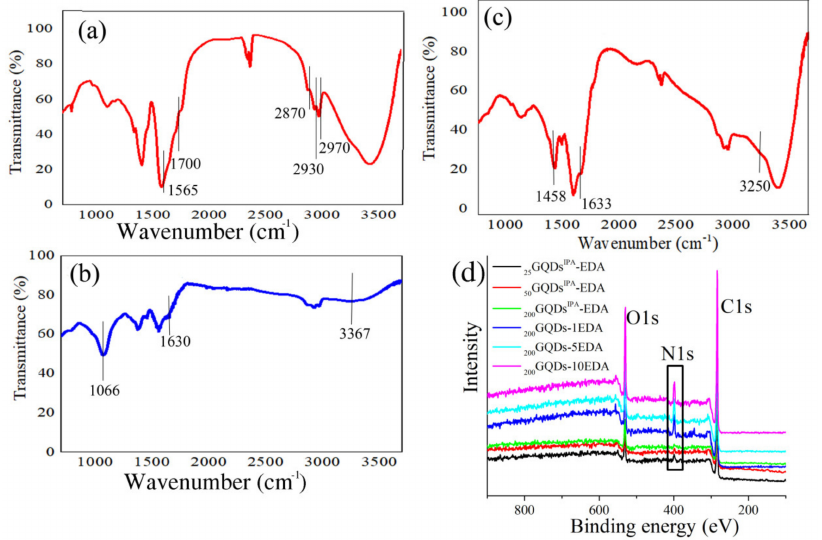
Figure 6. FTIR spectra of p-GQDs ( a ), 25 GQDs IPA -EDA ( b ), and 200 GQDs-10EDA ( c ) samples; XPS spectra of 25 GQDs IPA -EDA, 50 GQDs IPA -EDA, 200 GQDs IPA -EDA, 200 GQDs-1EDA, 200 GQDs-5EDA, and 200 GQDs-10EDA ( d